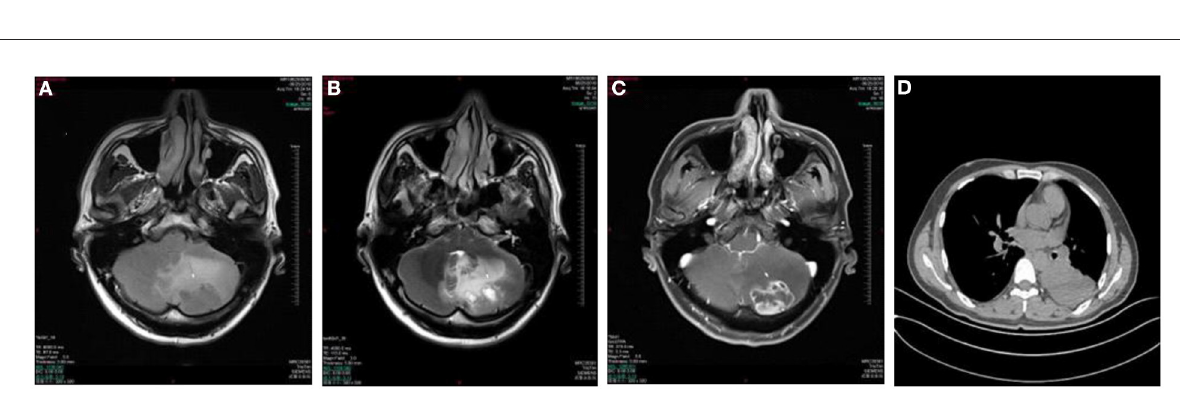
bed to the left, accompanied by visual rotation and mild